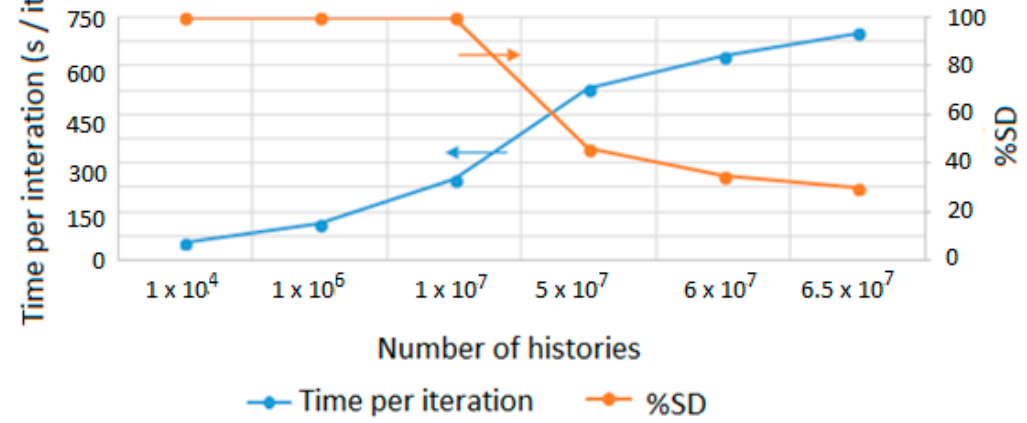
Figure 8. Results of the radiation factor (number of histories in Monte Carlo model) independence analysis.